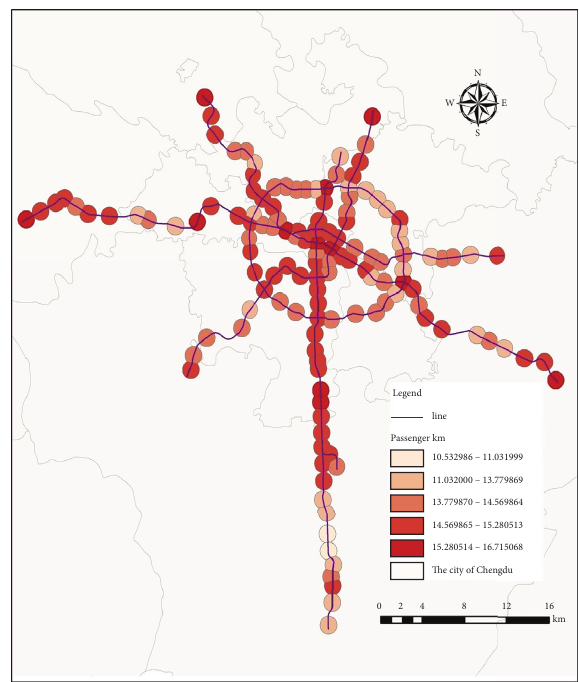
Figure 9: The spatial distribution of the logarithm of passenger- distance in Chengdu